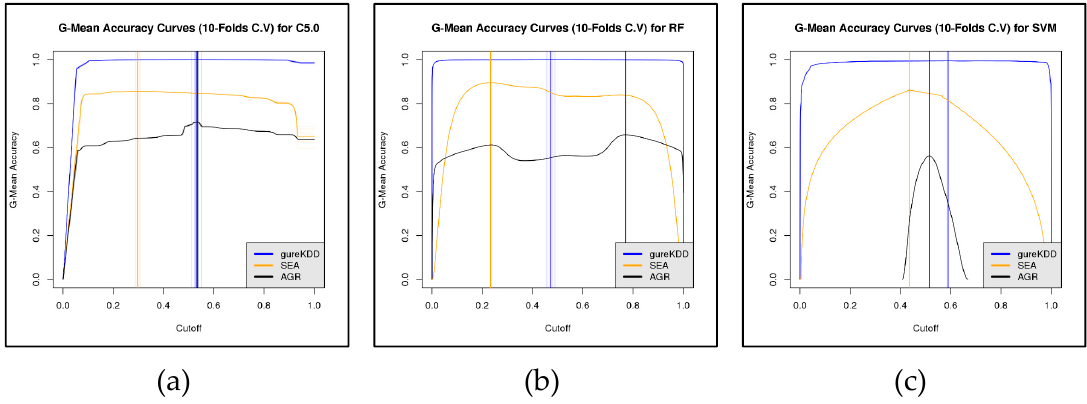
Figure 5. The gAcc curves of the 10 runs of the 10-folds cross-validation experiments for the three datasets (gureKDD, SEA and AGR) using three classification algorithms. ( a ) C5.0. ( b ) Random Forest. ( c ) SVM.